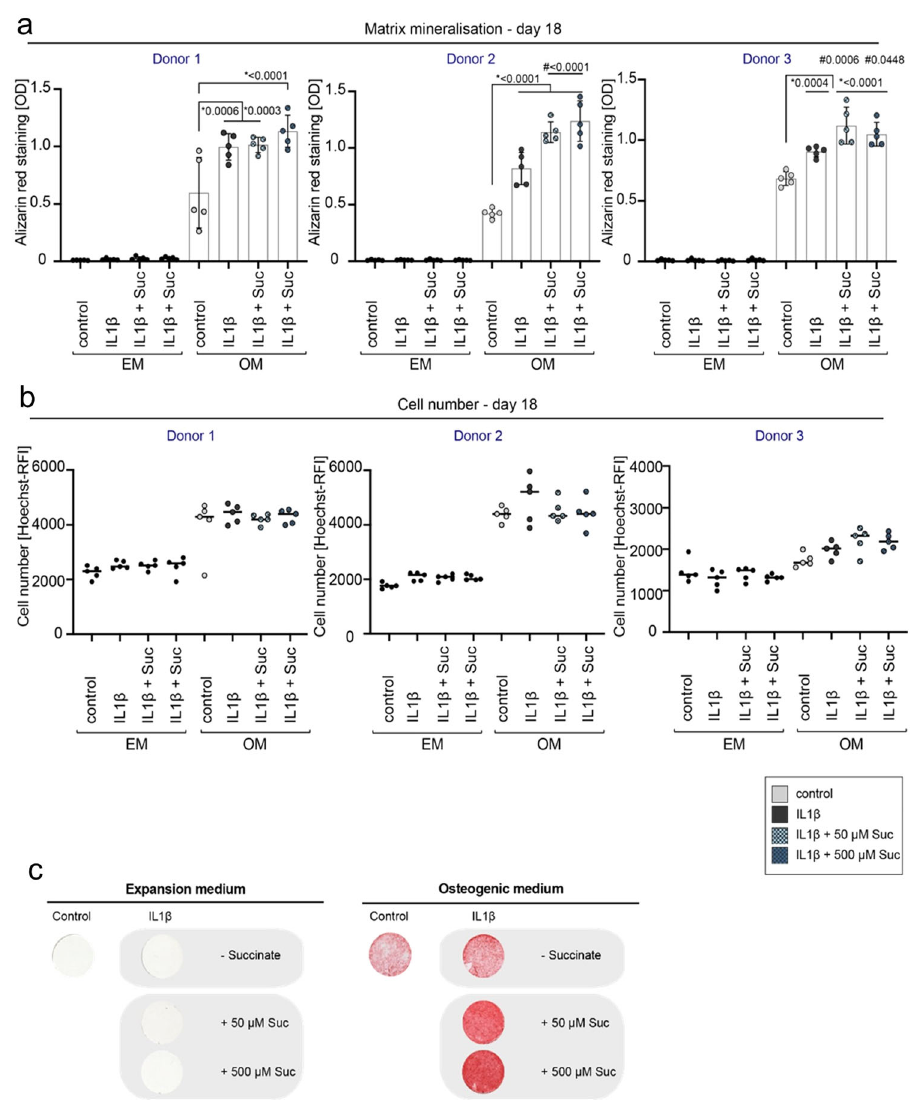
Fig. 9 Combination of transient IL-1 β and succinate stimulation during osteogenic differentiation of human MSCs strongly increases osteogenic differentiation potential in vitro. a Addition of IL-1 β (0.1 ng/ml) for 24 h after the induction of osteogenic differentiation resulted in increased levels of mineralized matrix compared to control osteogenic conditions (OM without succinate) after 18 days. Simultaneous addition of succinate (50 µ M, 500 µ M) to IL-1 β conditions, let to a further increase in mineralized matrix levels. n = 5 individual experimental replicates per donor, *signi fi cant to OM control, # signi fi cant to OM + IL-1 β treatment, by One-way ANOVA. Shown are mean ± standard deviation. b Cell numbers as determined by Hoechst staining is not altered between the treatments (control versus IL-1 β versus succinate) at day 18 of differentiation. N = 5 individual experimental replicates per donor, dot plot shows the mean, One-way ANOVA. c Exemplary light microscopic pictures of alizarin red staining at day 18 shown for osteogenic conditions versus non-osteogenic control conditions and IL-1 β ± succinate treated wells. EM expansion medium, OM osteogenic medium, IL-1 β interleukin 1 beta, Suc succinate, OD optical density, RFI relative fl uorescence